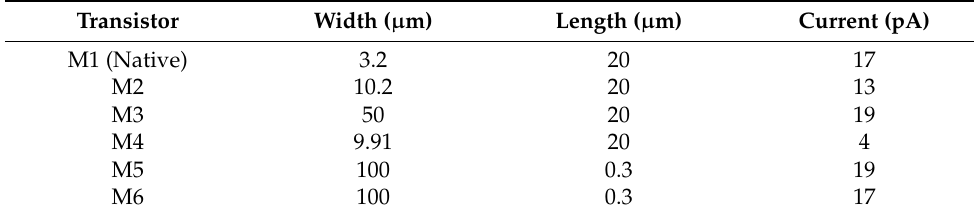
Table 1. MOSFET dimensions of the proposed circuit.